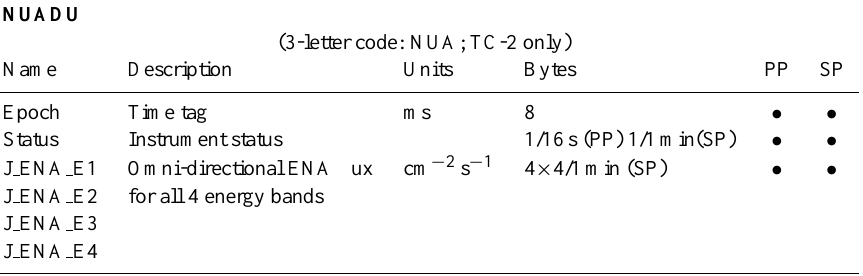
(3-letter code: NUA; TC-2